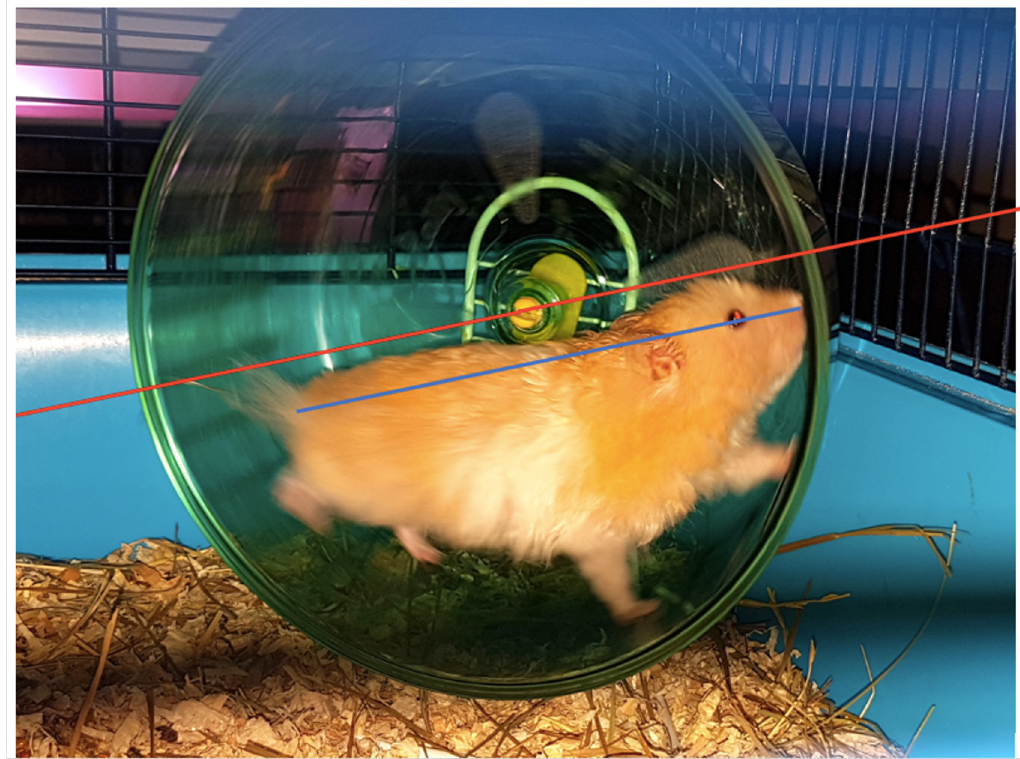
Fig 4. A running wheel with markedly undersized diameter. Red line: Desired diameter (= 2 × body length) of the running wheel. Blue line: Approximate body length of the pictured animal. (Photo: M. Ebner, 2018.).